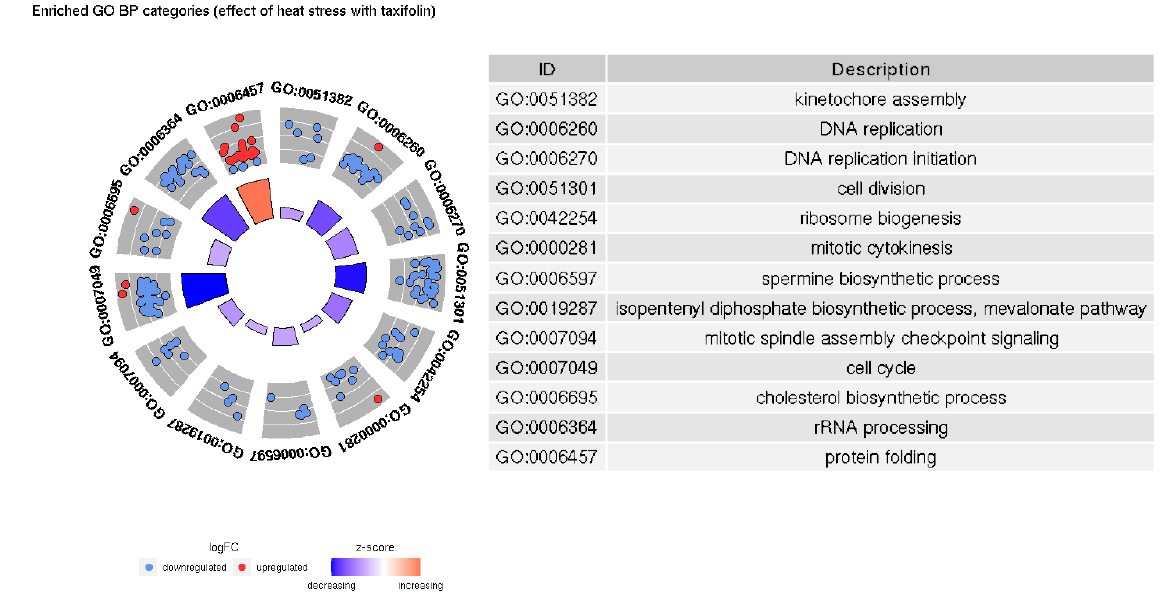
Figure 5. Significantly enriched GO BP categories in the HSnoTno/HSyesTno contrast.